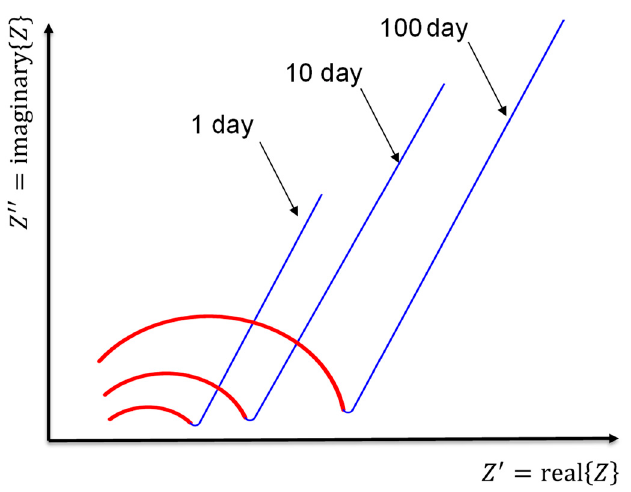
Figure 15. Nyquist plots of the cement-based samples of McCarter [150] over a period of 1, 10, and 100 days.